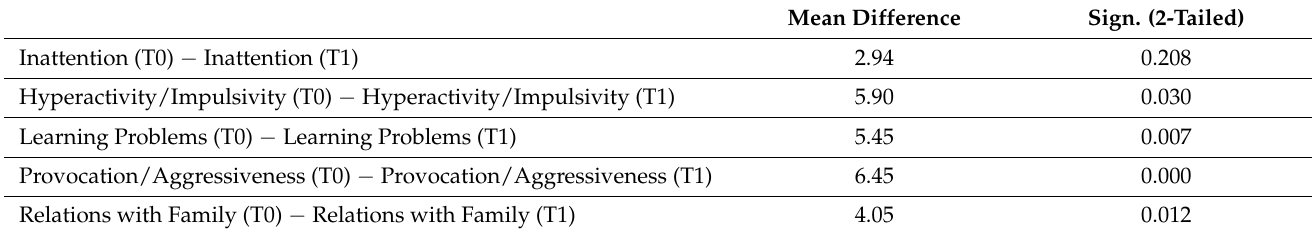
Table 4. T-test for mean differences for paired samples of the T-scores on the Conners-3 scale (T0 − T1).